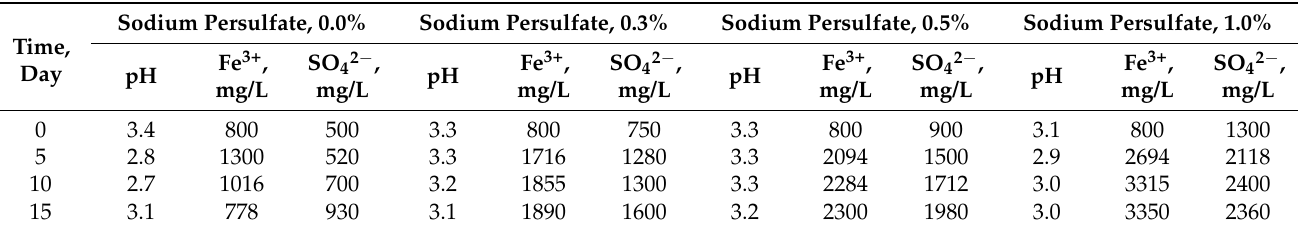
Table 5. Effect of sodium persulfate on the bioleaching of iron and sulfates from arsenopyrite flotation concentrate by A. ferrooxidans